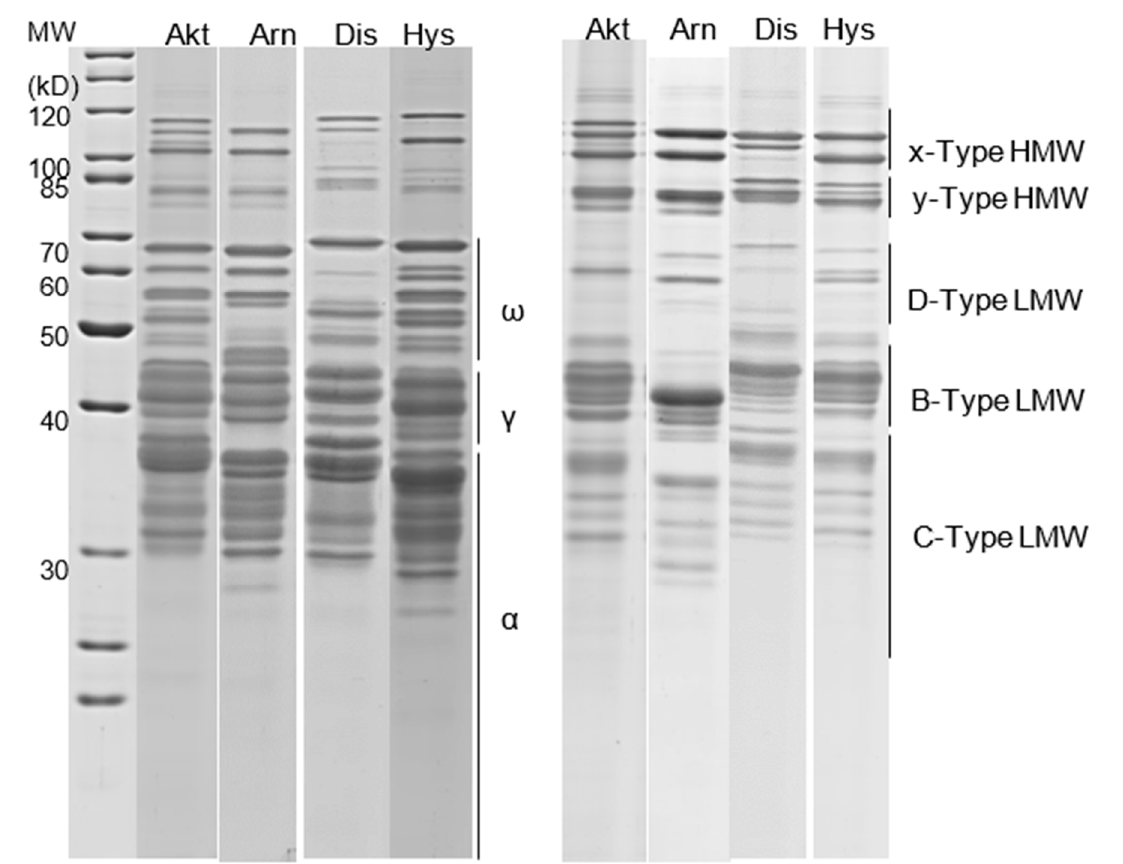
Figure 1. Separation of the GLIA ( left ) and GLUT fraction ( right ) by SDS-PAGE. Each line represents the band pattern of a cultivar (Akt, Akteur; Arn, Arnold; Dis, Discus; Hys, Hystar) grown at the high N level. The lines indicate the protein bands that were combined into the GLIA fractions ω , γ and α and into the GLUT fractions x- and y-type HMW-GS and D-, B- and C-type